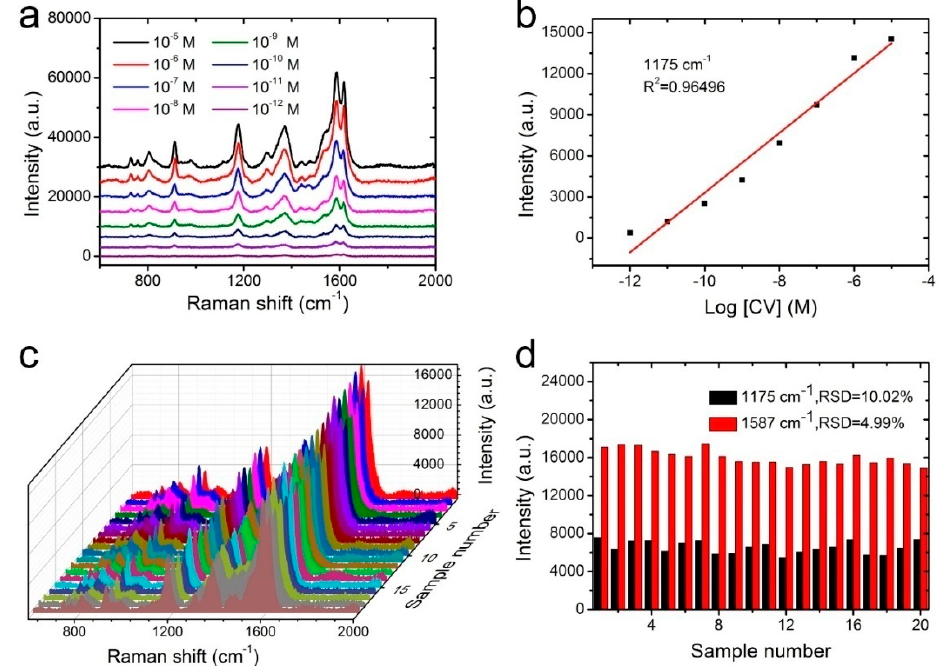
Figure 5. ( a ) SERS spectra of CV at different concentrations on the NW@PDA@AgNPs fabrics. ( b ) The calibration curve of characteristic peak intensity at 1175 cm − 1 with the logarithm values of sample concentration. ( c ) The stability of SERS substrate from 20 random points probed with CV molecules. ( d ) Intensity distribution of CV at 1175 and 1587 cm − 1 , collected from 20 different NW@PDA@AgNPs fabrics.